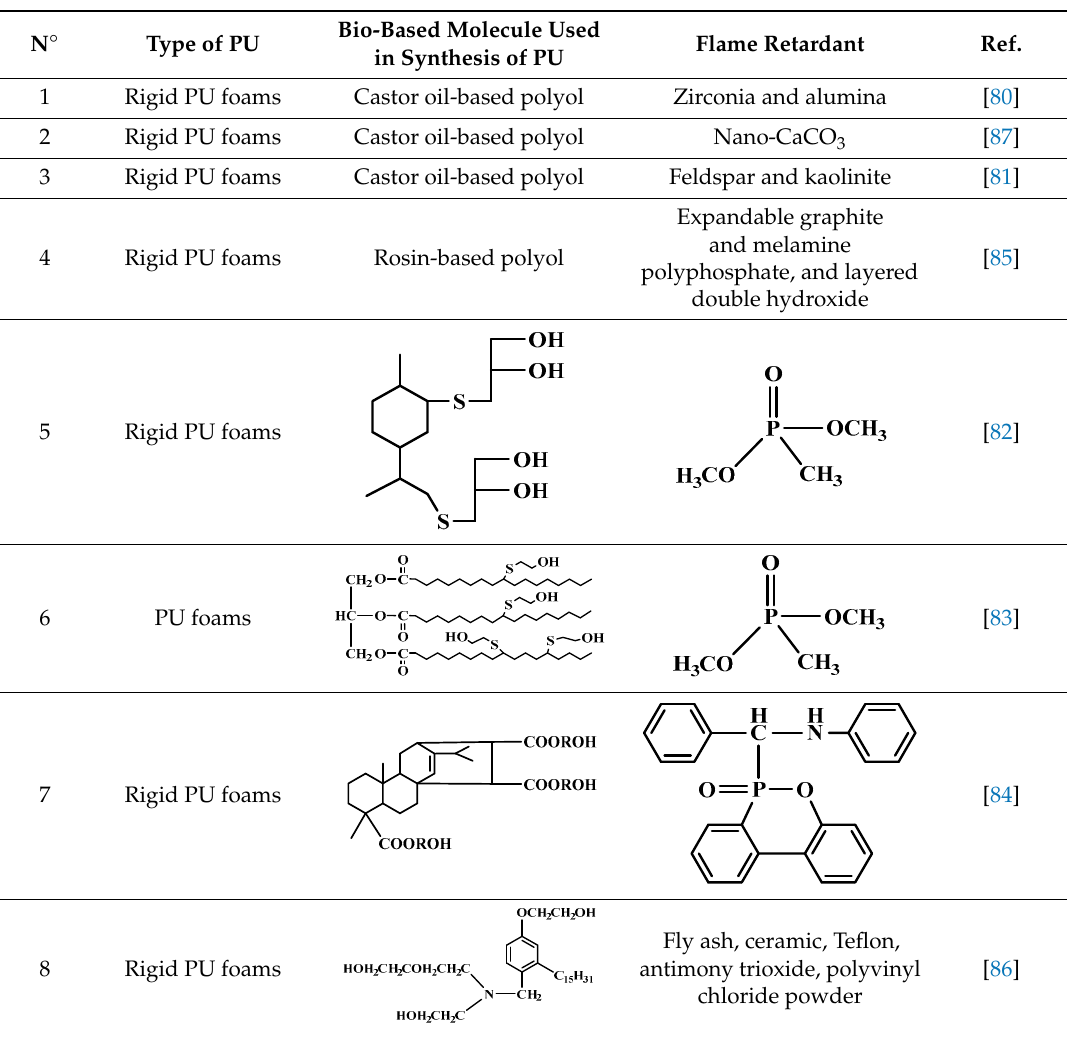
Table 2. Summary of “additive” flame-retardant bio-based PUs (Numbers 1 to 4 correspond to the “inorganic”, while numbers 5 to 7 correspond to the “organic”, and number 8 corresponds to both “inorganic and organic” flame-retardant additives).